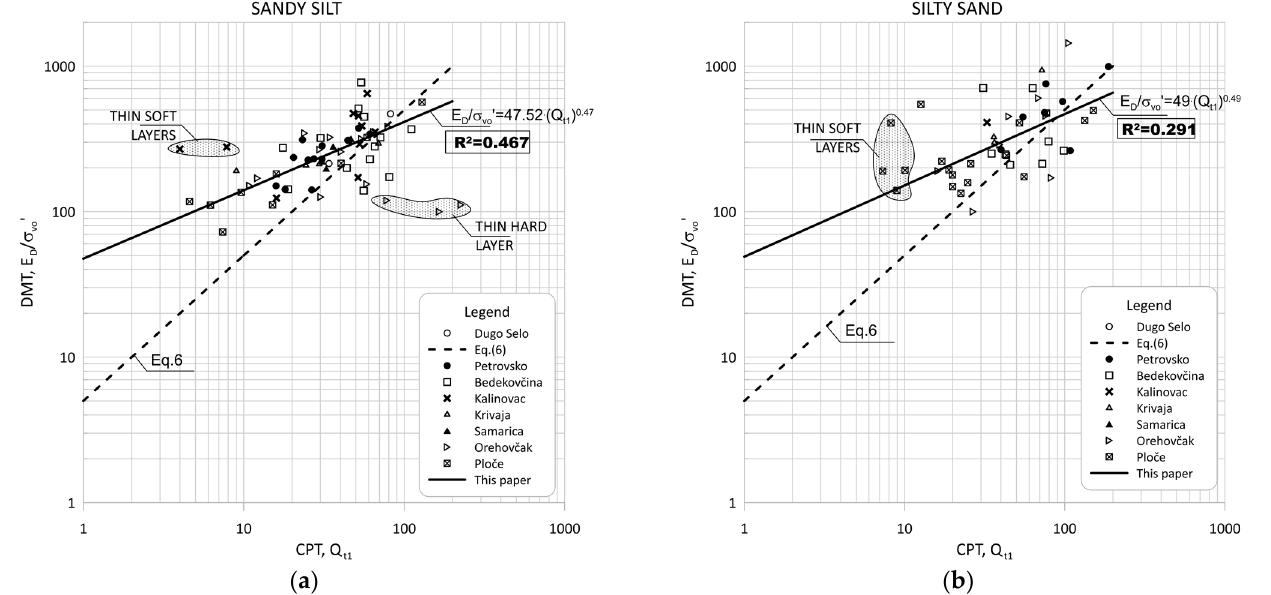
versus 𝑄𝑄 𝑡𝑡1 𝐸𝐸 𝐷𝐷 𝜎𝜎′ 𝑣𝑣0 ⁄